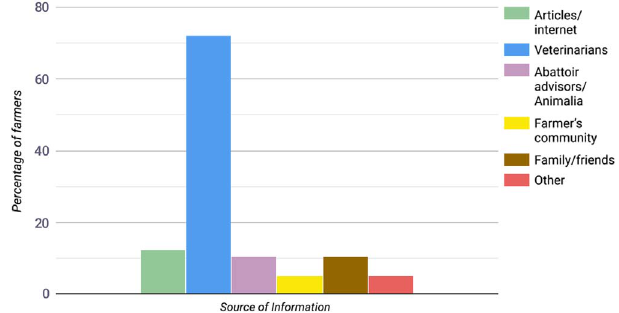
Figure 2. Most important advisor for parasite treatment perceived by the farmers (members of NSRS, Animalia). Possible to select several alternatives, thus total percentage exceeds